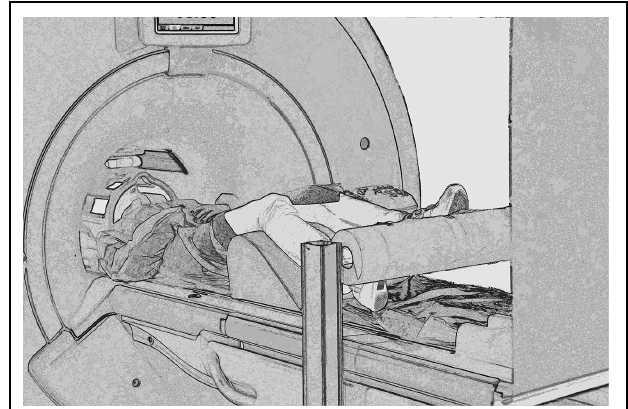
FIGURE 2 | Experimental set up. Picture showing a participant walking on the rolling cylinder while being scanned.